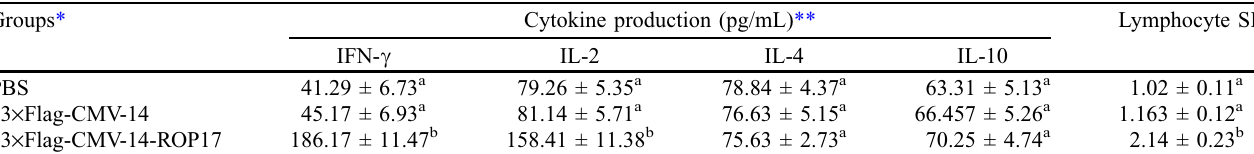
Table 1. Cellular proliferation and cytokine production by splenocytes isolated from ROP17 DNA-immunized BALB/c mice and controls.